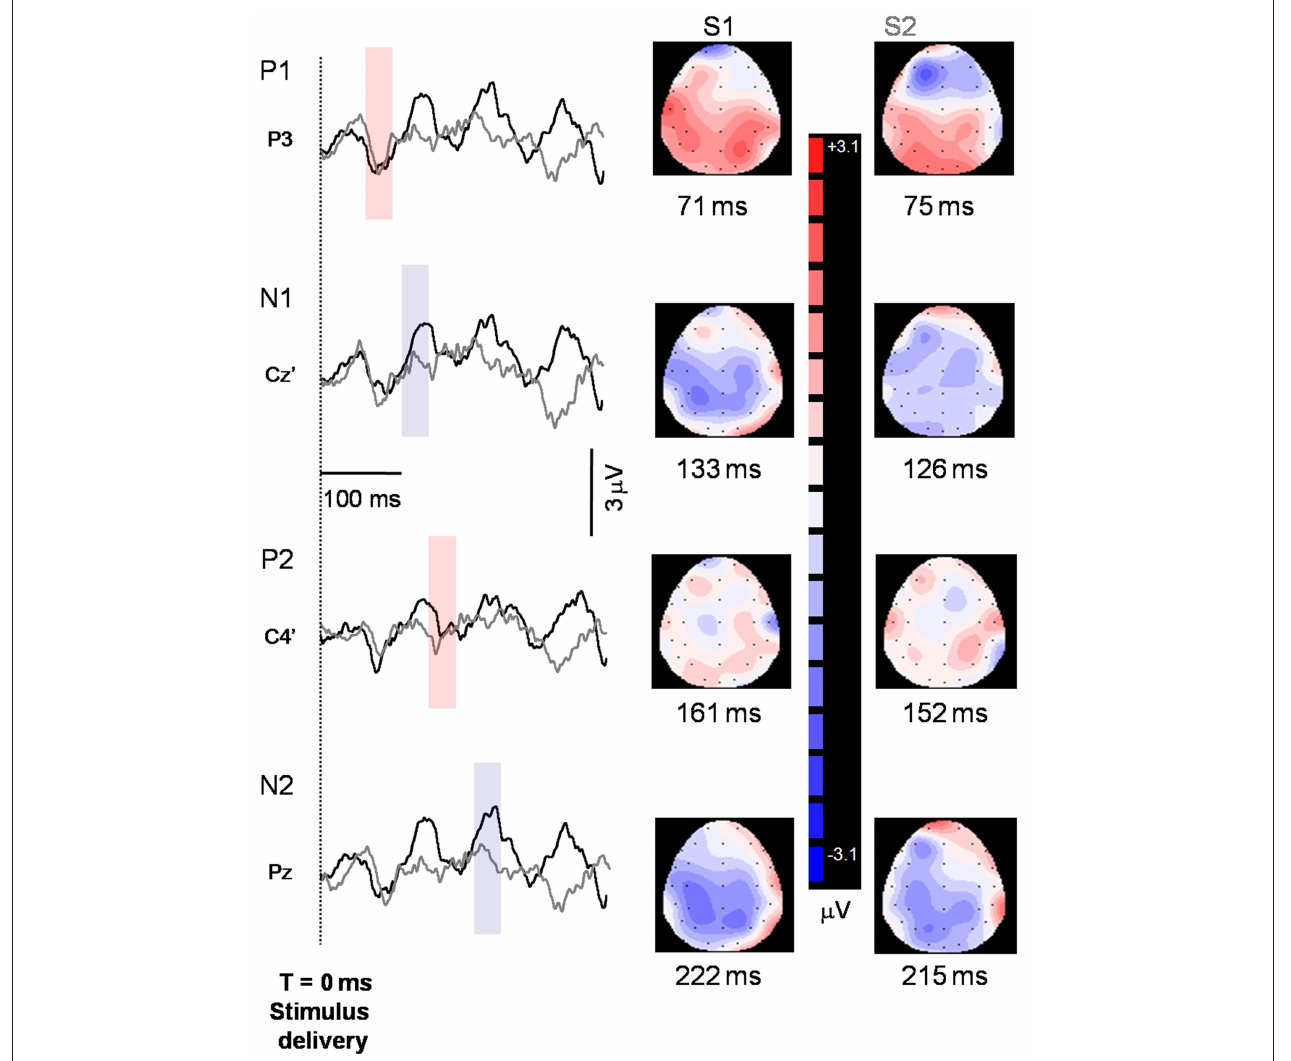
peaks were identified for the two stimuli and correspond temporally to the 2-D maps on the right side of the figure. Note that downward deflections indicate more positive polarity. Baseline was established from a 100-ms pre-stimulus